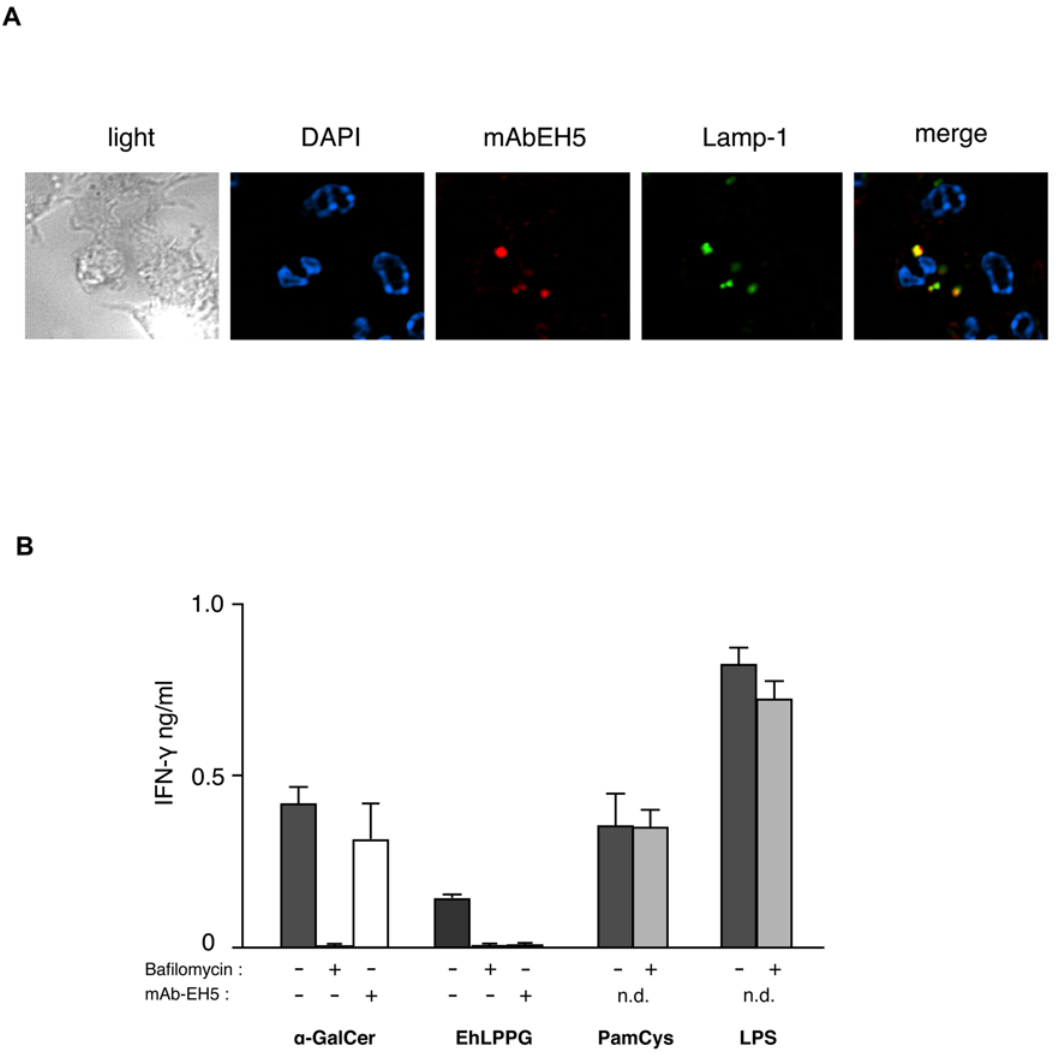
Figure 7. EhLPPG is internalized and requires processing or endosomal trafficking for activation of NKT cells. (A) WT APC were pulsed with 20 m g/ml EhLPPG for 3 h, fixed with 4% PFA and permeabilized with 0.5% saponin; EhLPPG was labeled with mAb EH5 [28] and anti Lamp-1 mAb was used for detection of late endosomes by confocal microscopy. The experiment was performed four times. (B) Treatment of APC with an inhibitor of endocytosis, bafilomycin A1 (10 nM, 30 min), led to a decrease in the IFN- c production in NKT cells after stimulation with a -GalCer (4 m g/ ml) and EhLPPG (10 m g), but not with PamCys (4 m g/ml) and LPS (1 ng/ml). The addition of mAb EH5 (100 m g/ml) to APC pulsed with a -GalCer and EhLPPG specifically inhibited the IFN- c secretion of cocultured NKT